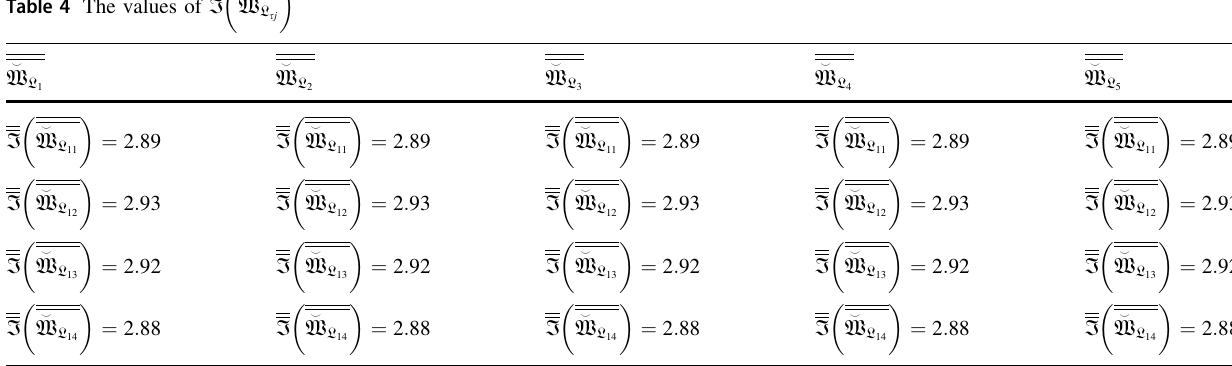
Table 4 The values of I W ^ L